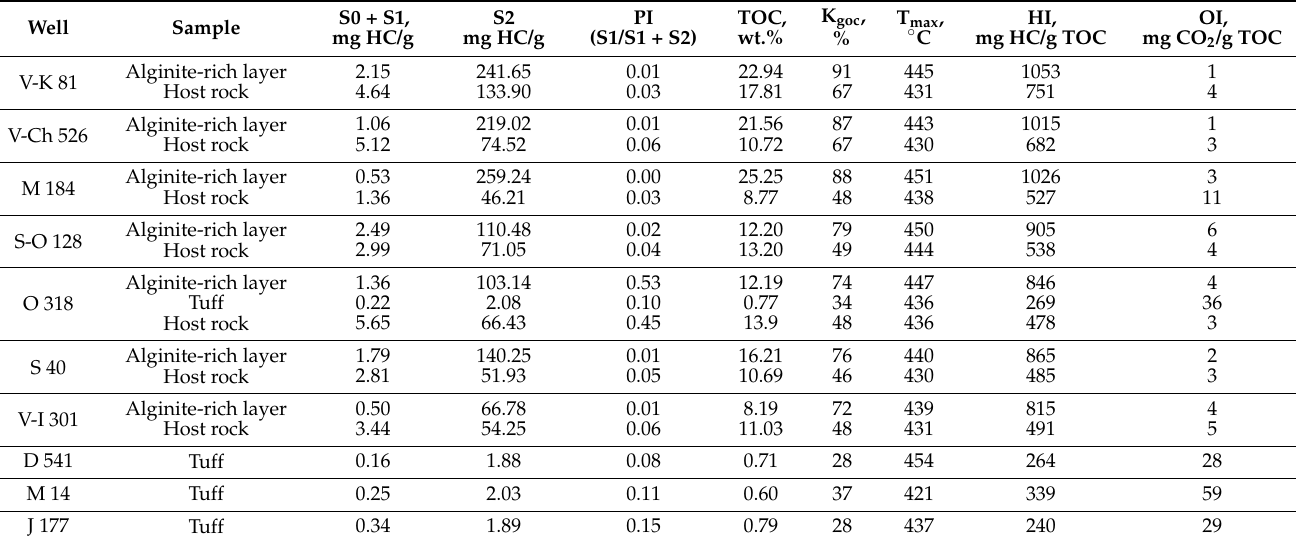
Table 1. Rock-Eval pyrolysis data for the alginite-rich layers, host rocks, and tuffs.